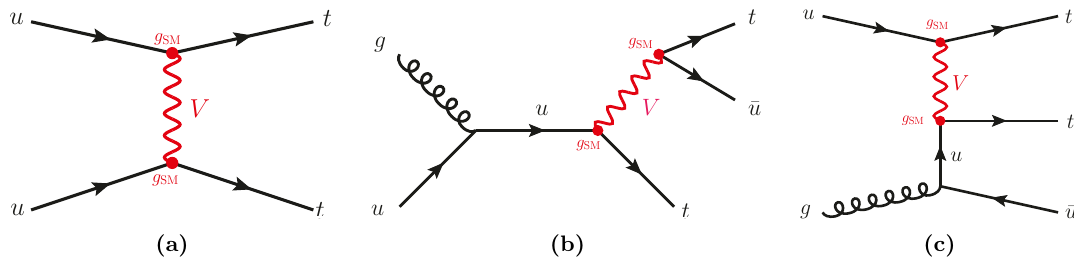
Figure 3 . Three examples of same-sign top quark pair signatures in the context of the dark- matter mediator model: (a) prompt tt production, (b) via an on-shell mediator, (c) via an o(cid:11)-shell mediator. The mediator is denoted by V and its coupling to SM particles is denoted by g SM